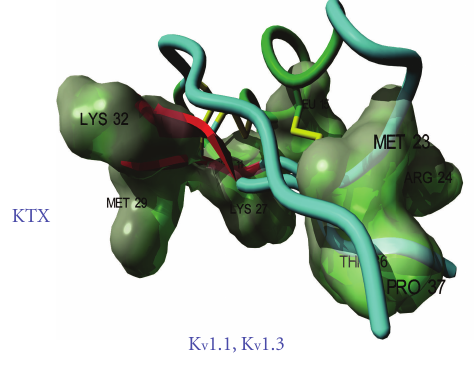
Figure 3: Amino acid sequence and 3D structure of KTX. The crucial amino acid residues involved in the receptor recognition are in red and are materialized on the 3D structure according to Lange et al., 2006 [13]. The α -helix is in green, the β -sheet in red. Arrows in red indicate the three peptides able to compete (K d = 100 nM) with the 125 I-KTX bound to its binding site on rat brain synaptosomes